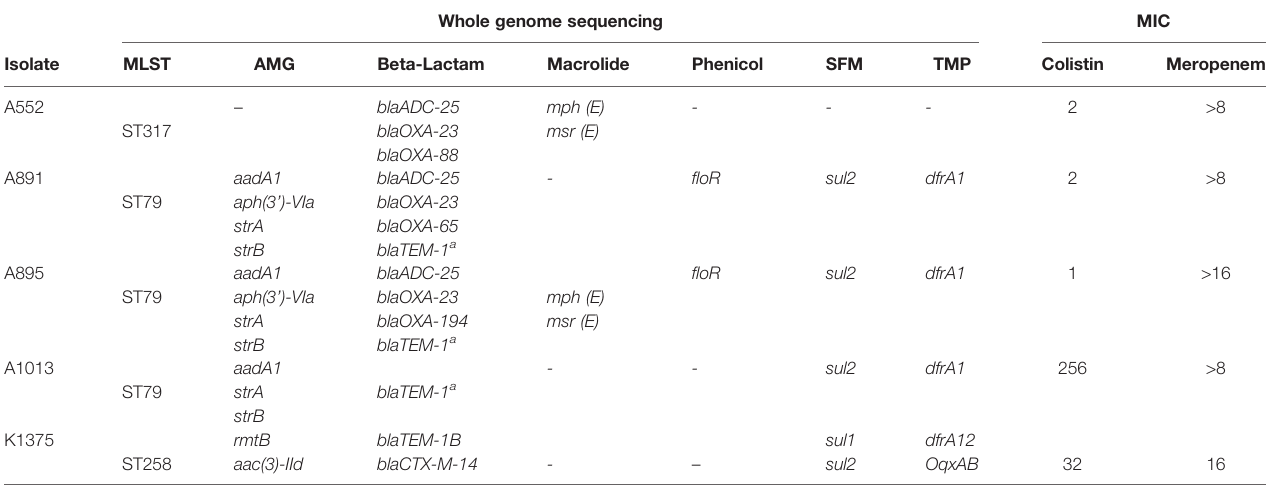
TABLE 1 | Resistance pro fi le of A. baumannii isolates and the K. penumoniae K1375 used in this